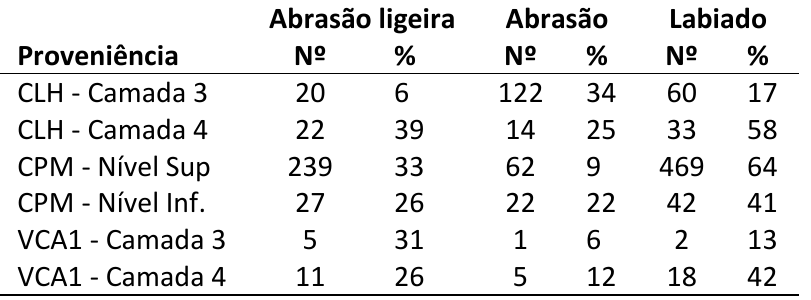
Tabela 4. Número e percentagem de peças apresentando vestígios de abrasão (ligeira e evidente) e labiado. Table 4. Number and percentage of pieces presenting traces of abrasion (slight and marked) and lip. VCA1 - Abrigo 1 de Vale. Covões; CLH - Lapa dos Coelhos; CPM I - Cabeço de Porto Marinho I.